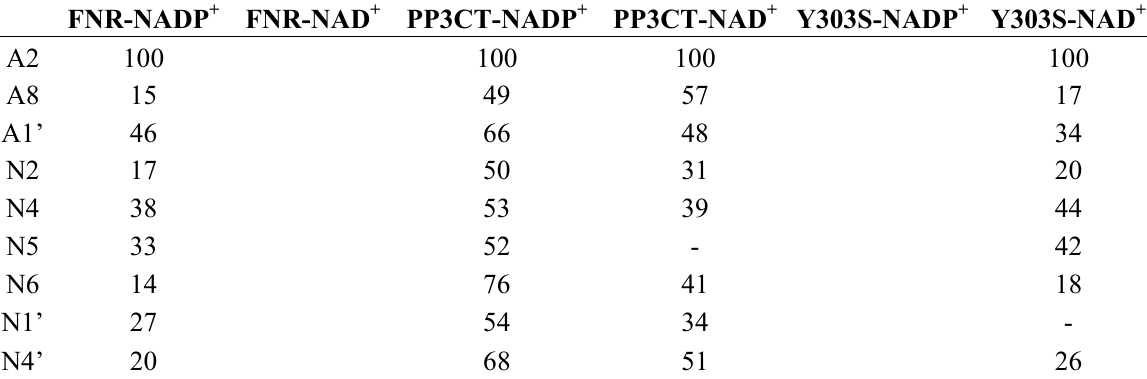
Table 3. STD initial growing rate relative values for Saturation Transfer Experiments, normalized against the larger STD initial growing rate (100%), performed for the complexes between WT Anabaena FNR, PP3CT and FNR:Y303S with NADP + and NAD +